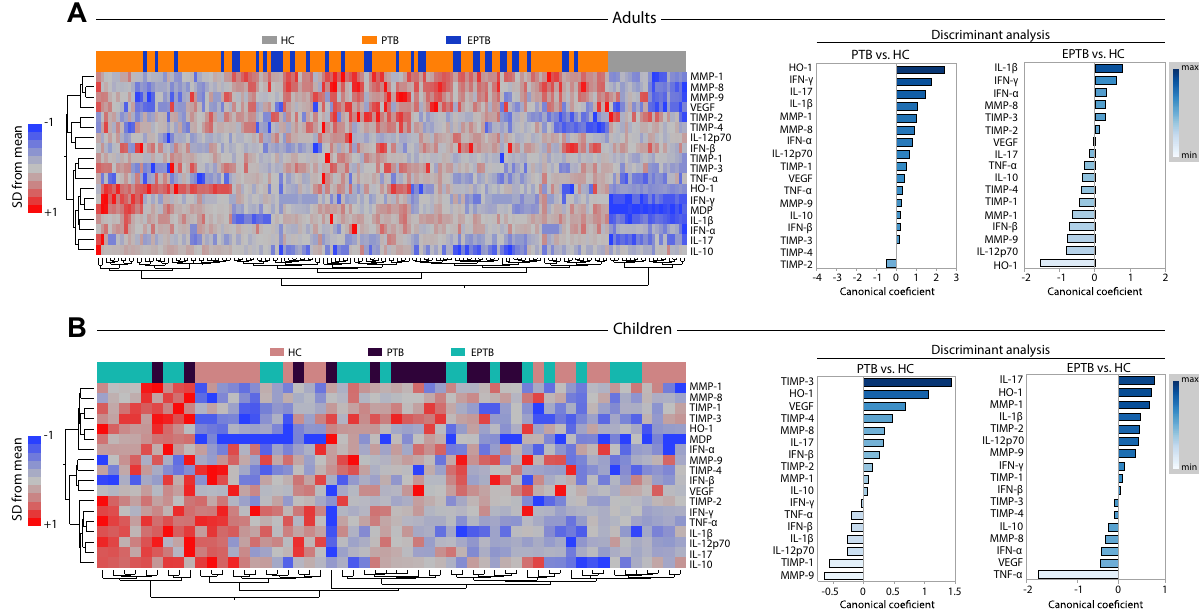
Figure 2. Plasma biomarkers driving the overall molecular degree of perturbation in pulmonary tuberculosis are distinct between adults and children. ( A , B ) Left panels: Unsupervised two-way hierarchical cluster analyses (Wards method with 100 × bootstrap) using the MDP values (z-score normalized) for each individual markers measured in plasma from patients from both groups were employed to test if simultaneous assessment of such markers could group PTB or EPTB separately from healthy individuals. Dendrograms represent Euclidean distance. Right panels: A discriminant analysis model based on canonical correlation analyses was used to identify the markers which are driving the discrimination between the study groups. Number of patients per group: Adult HC: n = 20, Adult PTB: n = 97, Adult EPTB: n = 35, Child HC: n = 18, Child PTB: n = 14, Child EPTB: n =